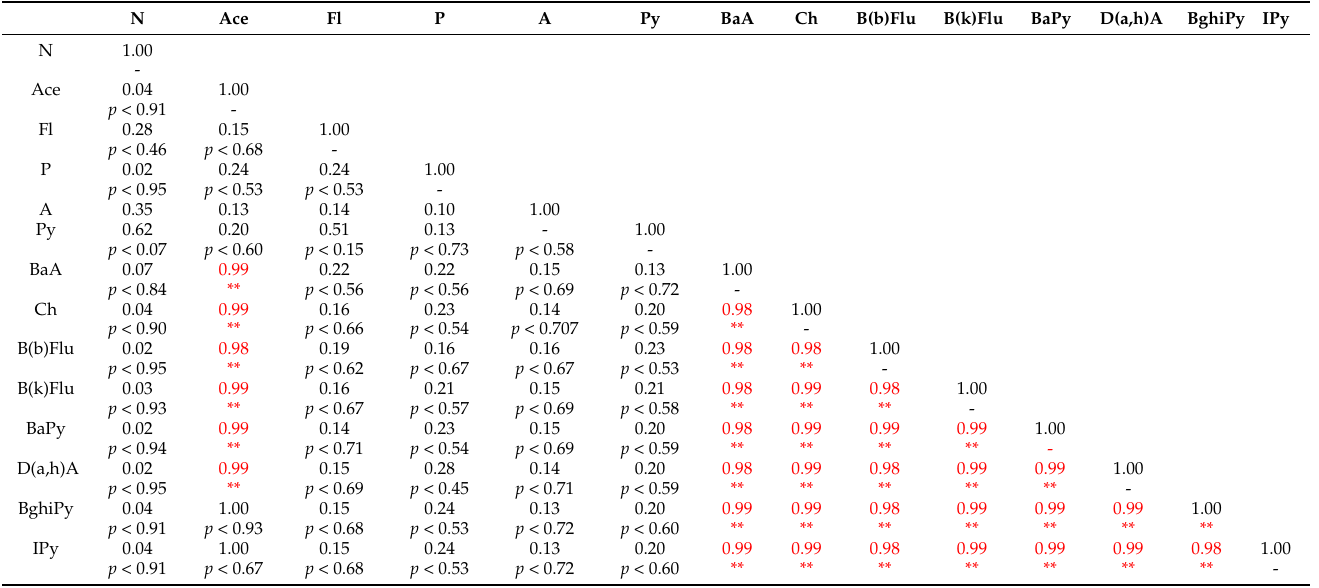
Table 5. Application of the Spearman correlation to contents of the PAHs in blood serum of non- smokers patients with